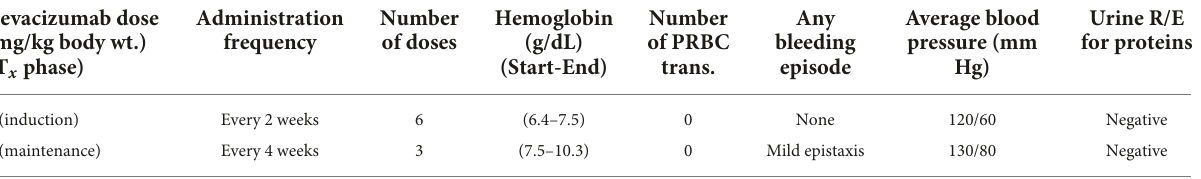
TABLE 2 Dose and frequency of administration of bevacizumab and follow-up parameters. Bevacizumab dose (mg/kg body